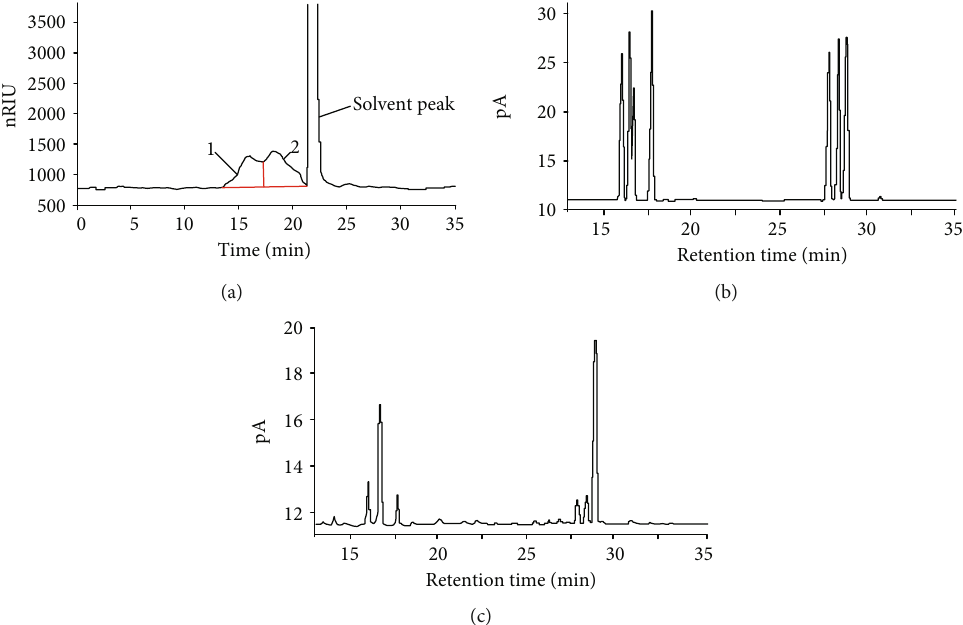
Figure 2: Molecular weight and gas chromatography analysis of CPP. (a) High-performance liquid chromatogram, (b) gas chromatogram of monosaccharide standard, and (c) gas chromatogram of CPP